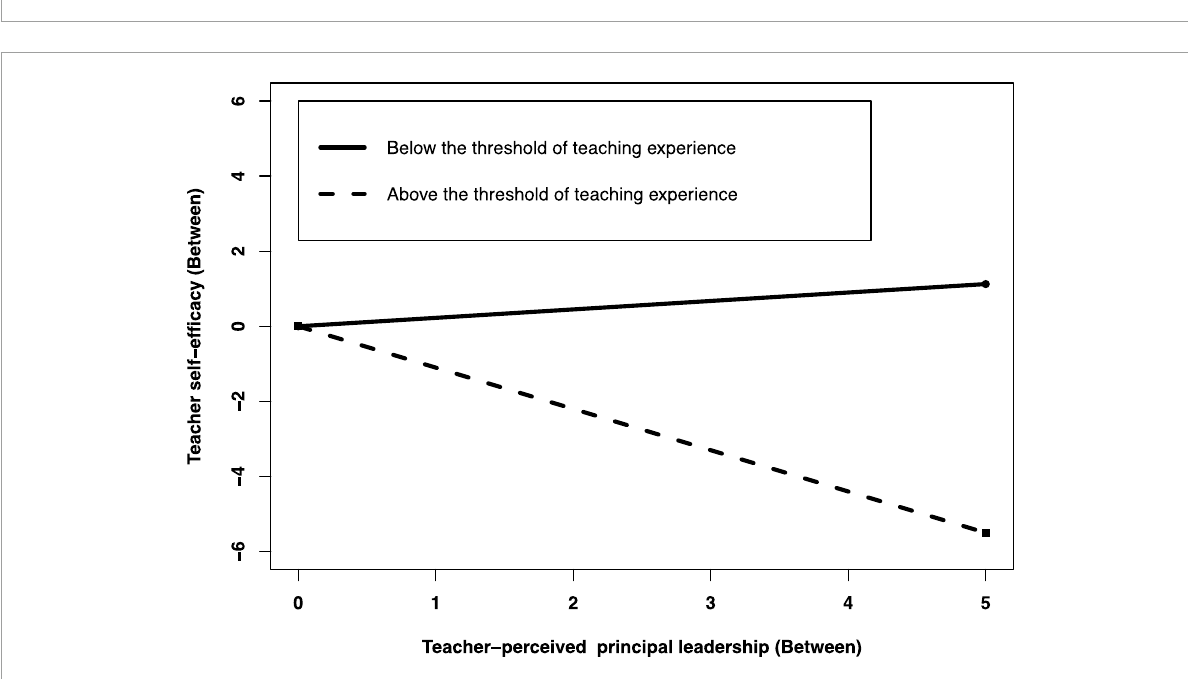
FIGURE4 Teaching experience as a moderator of the indirect effect between teacher-perceived principal leadership and teacher self-efficacy through teacher collaboration at the between-group level. Functions are graphed for two levels of positive coping: Teaching experience below and above a